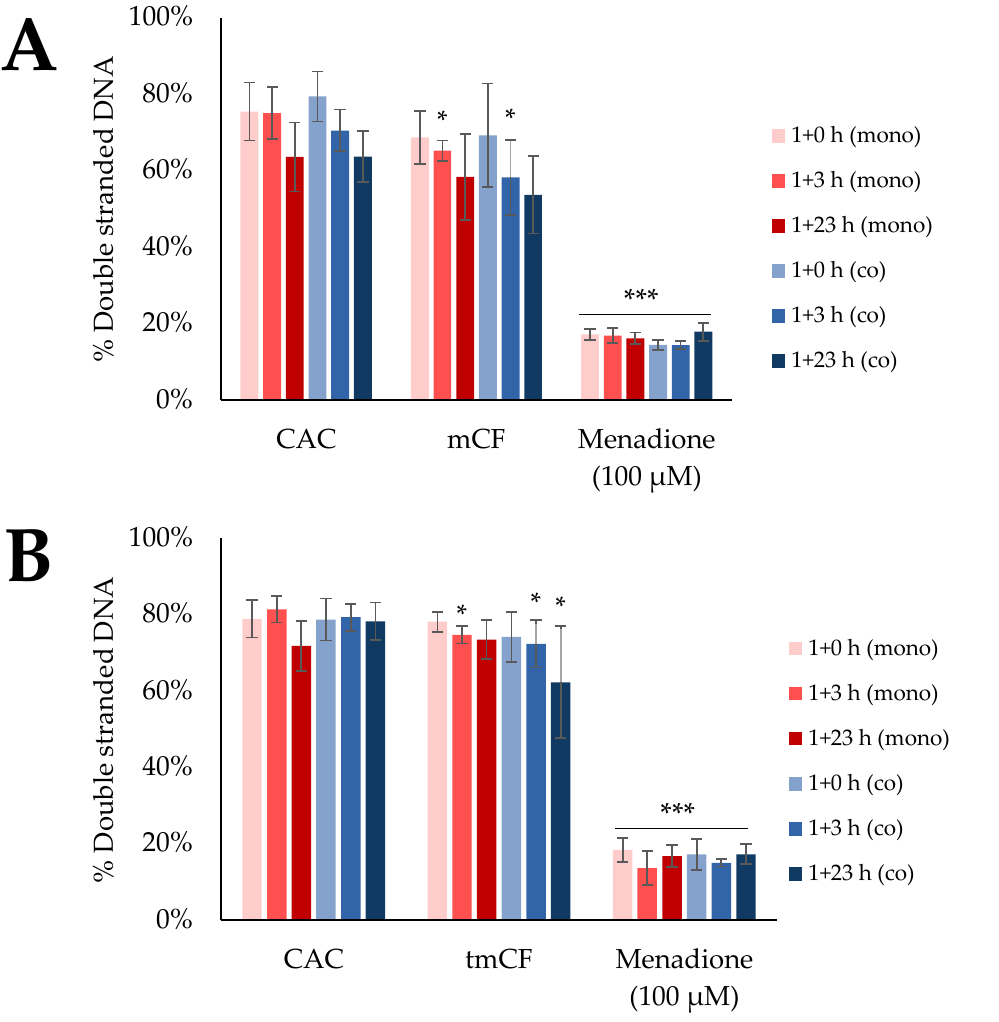
Figure 8. Assessment of DNA strand breaks after exposure of BEAS-2B mono-cultures and BEAS-2B/dTHP-1 co-cultures to mechanically (mCF; ( A )) or thermo-mechanically treated (tmCF; ( B )) carbon fibers (CF). BEAS-2B cells were seeded as mono-cultures at a density of 2 × 10 5 /cm 2 . For co-culture treatment, dTHP-1 cells were seeded on top with a density of 3.95 × 10 4 /cm 2 after 4 h. The next day, mono- and co-cultures were exposed to CF samples with average surface doses of 7.00 ± 1.25 µg/cm 2 (mCF) or 6.55 ± 1.96 µg/cm 2 (tmCF) and post-incubated for 0, 3, or 23 h. Clean air con-